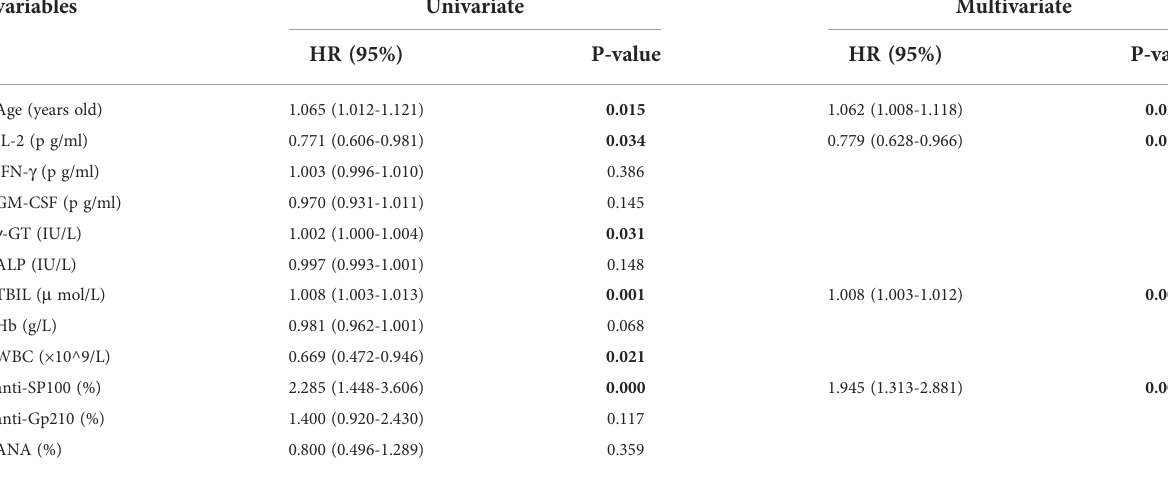
TABLE 3 Cox regression analysis of risk factors for liver failure in primary biliary